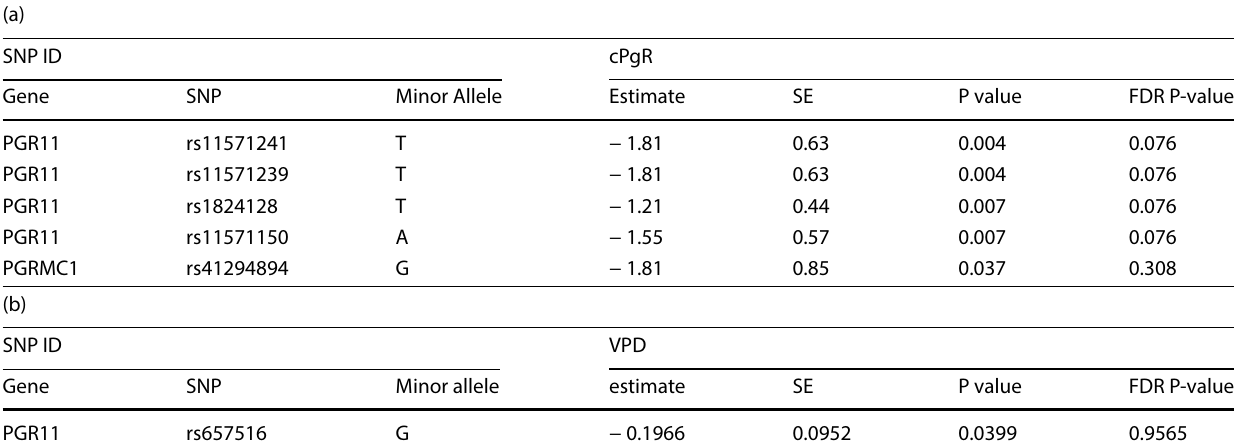
Table 3 Single nucleotide polymorphisms (SNPs) with significant multivariate adjusted (for the six covariates) associations among 42 SNPs: with genotype 1 frequency > = 3% and count > = 10) with (A) circulating Progesterone (cPgR), (B) volumetric Percent Density (VPD)